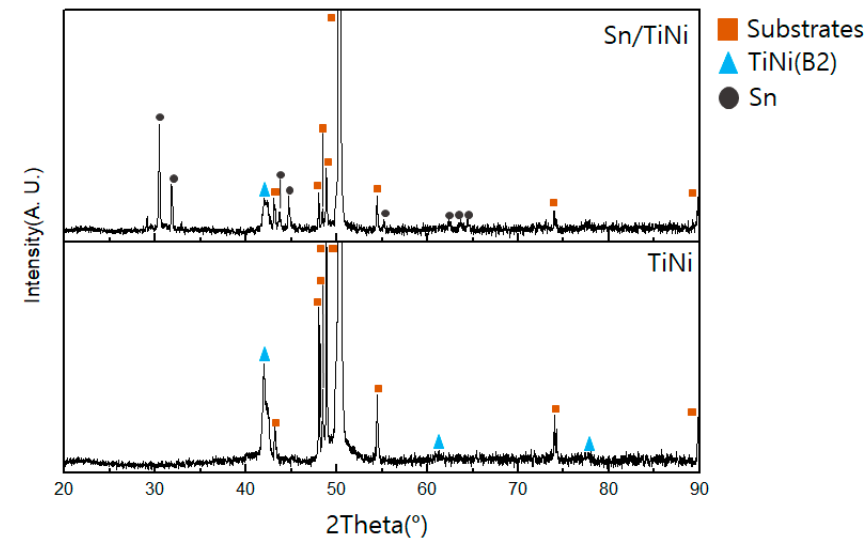
Figure 4. X-ray diffraction patterns of TiNi and Sn/TiNi thin films.